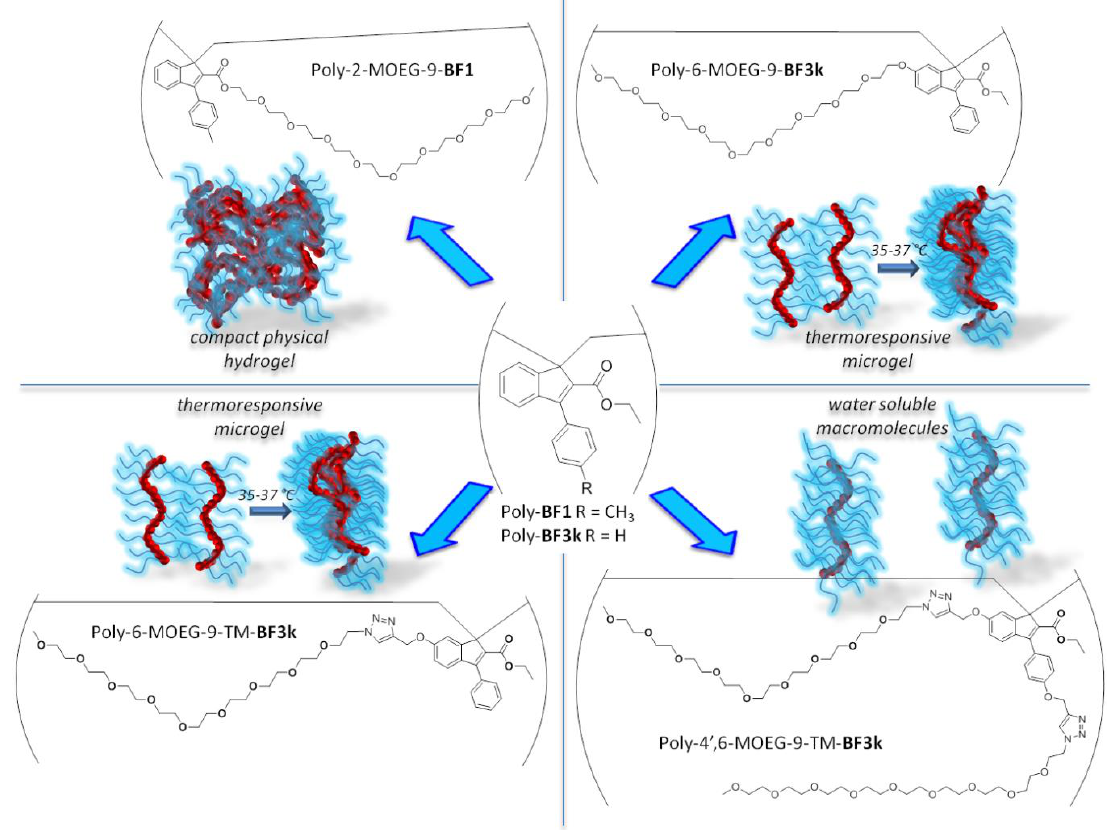
Figure 1. The previously proposed aggregation mechanism in PEGylated polybenzofulvene brush (PPBFB) derivatives.